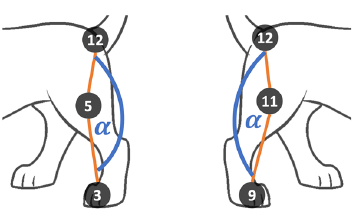
Figure 9. Calculation of the back leg